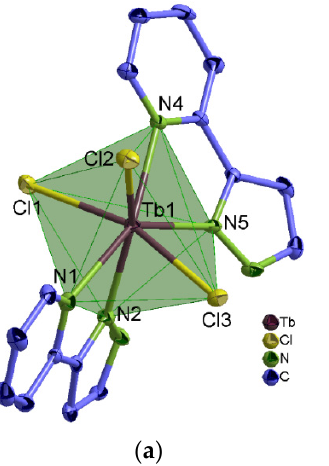
Figure 4. ( a ) Extended coordination sphere of the Tb 3+ ion in [Tb(2–PyPzH) 2 Cl 3 ] ( 12 ) representing the isotypic complexes 12 – 15 .; ( b ) packing structure of 12 with a view along